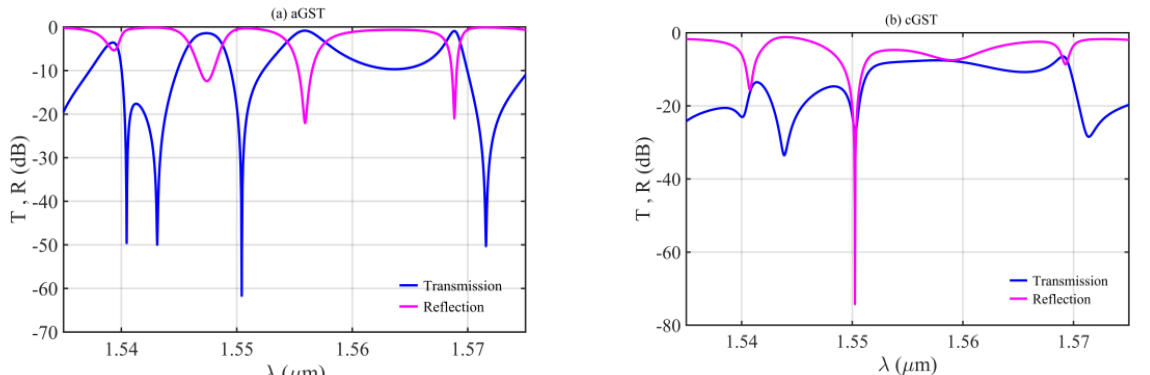
Figure 4. Transmission and reflection spectra of Sagnac ring coupled 1 × 3 MOMRs based on ( a ) aGST, and ( b ) cGST.